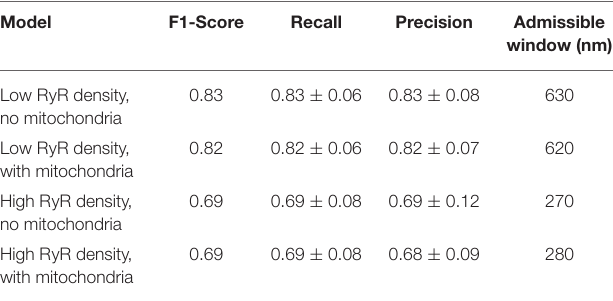
TABLE 2 | Ca 2+ release site detection performance results at the precision-recall break-even point, where Precision ≈ Recall and the number of false positives ≈ the number of false